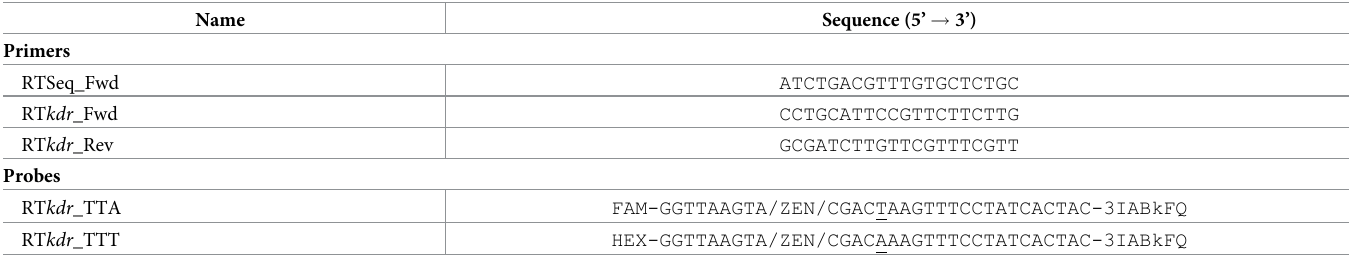
Table 1. Primers and probes. Underlined text indicates the location of the 1014